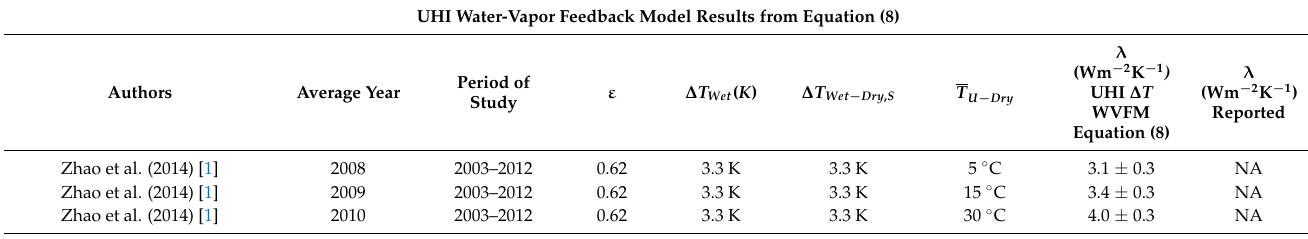
Table 2. UHI and general water-vapor feedback model